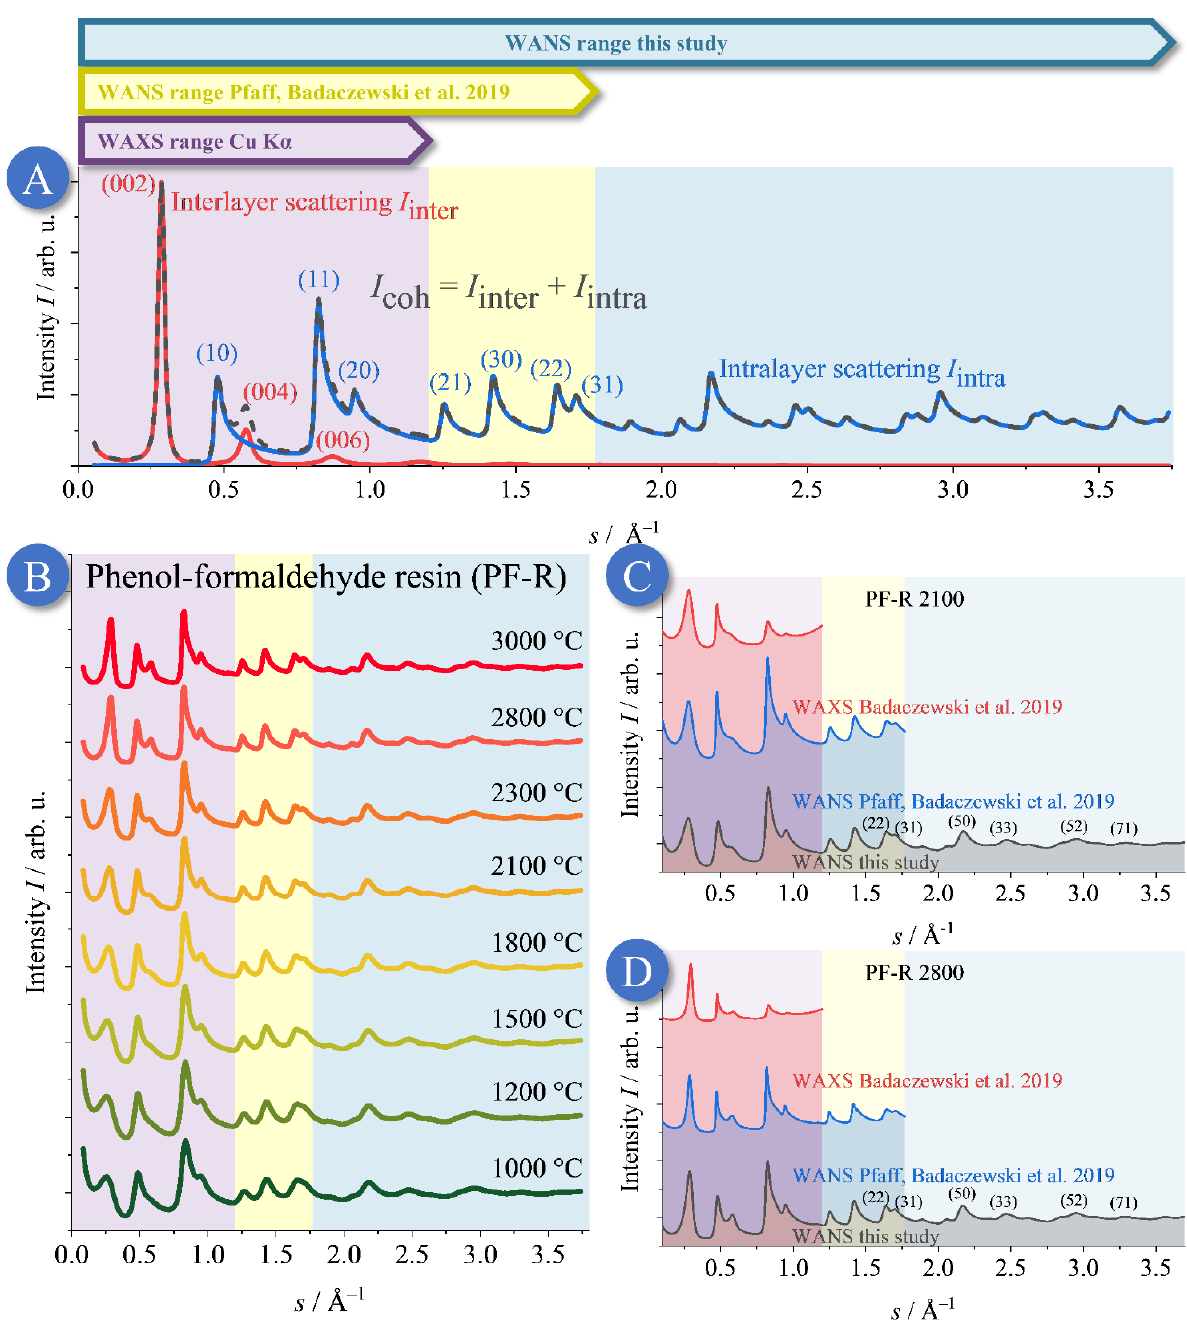
Figure 5. ( A ): The theoretical WANS intensity normalized per carbon (in electron units) I e.u. is given by a superposition of the interlayer ( I inter ) and intralayer ( I intra ) scattering. ( B ): WANS data of the phenol-formaldehyde resin (PF-R) carbon samples, including the previous WAXS (purple), the WANS (yellow) data, and the additional WANS range of the present study (blue). The temperature values represent the respective maximum heat treatment temperature. All these WANS data were already corrected for incoherent scattering using the procedure shown in Section S1 in the SI. ( C , D ): Comparison between the previously published WAXS (blue) and WANS (red) data from Pfaff et al. (2019) (blue), and the WANS measurements of this study, acquired at the Grenoble facility (black). Since in this present study, the accessible s -range was much larger than in Pfaff et al. (2019) [43] and Badaczewski et al. (2019) [37], the intralayer structure could be determined more accurately. By contrast, for the stacking, no improvements were possible, as the widths of the (00 l ) reflections for these carbons increased so strongly with increasing s that these reflections were dampened out at moderate s -values. The WANS data for the temperature series of the LSPP and MP samples (pitches) can be found in the SI file (Figures S6 and S8).